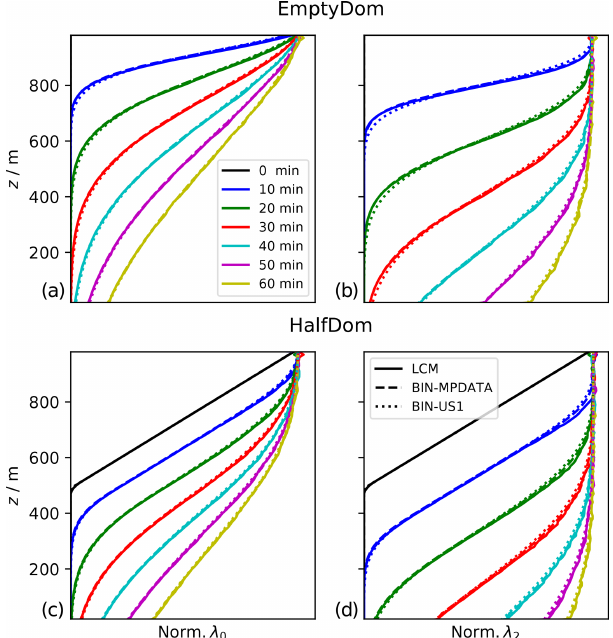
Figure A1. Pure sedimentation test case: comparison of BIN and LCM (solid) advection. BIN uses either MPDATA (dashed) or first-order upstream scheme (dotted). EmptyDom (a, b) and Half- Dom (c, d) set-ups are used with an exponential distribution with r init = 50µm as influx condition. Displayed are vertical profiles of normalised zeroth and second moment at the indicated points in time.